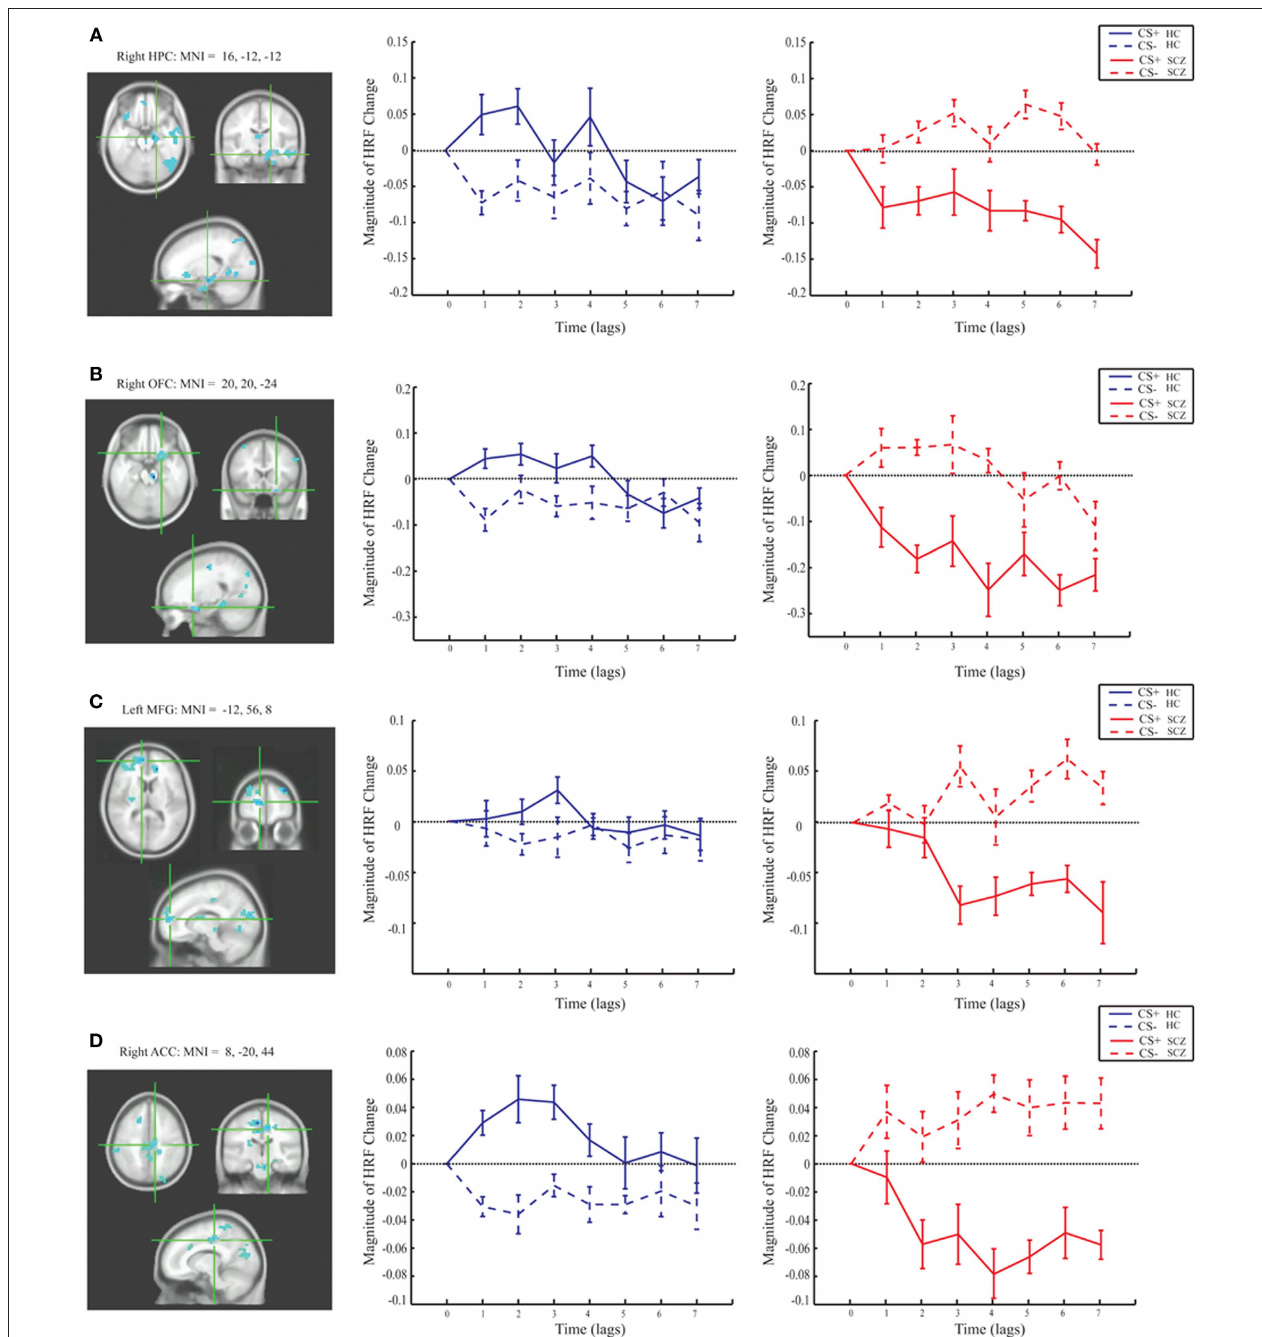
FIGuRe 4 | Magnitude HRF for the hippocampus, cingulate, and prefrontal regions from task PLS analysis (LV 1). The brain regions which showed increased activity in response to the CS + compared to the CS − in the control group, and the opposite pattern in the patient group also included: (A) the right hippocampus [MNI coordinates ( x , y , z ): 24, 16, − 28]; (B) right orbitofrontal cortex (BA 11; MNI: 20, 20, − 24); (C) left medial frontal gyrus (BA 10; MNI: − 12, 56, 8); (D) right anterior cingulate cortex (BA 32; MNI: 8, − 20,